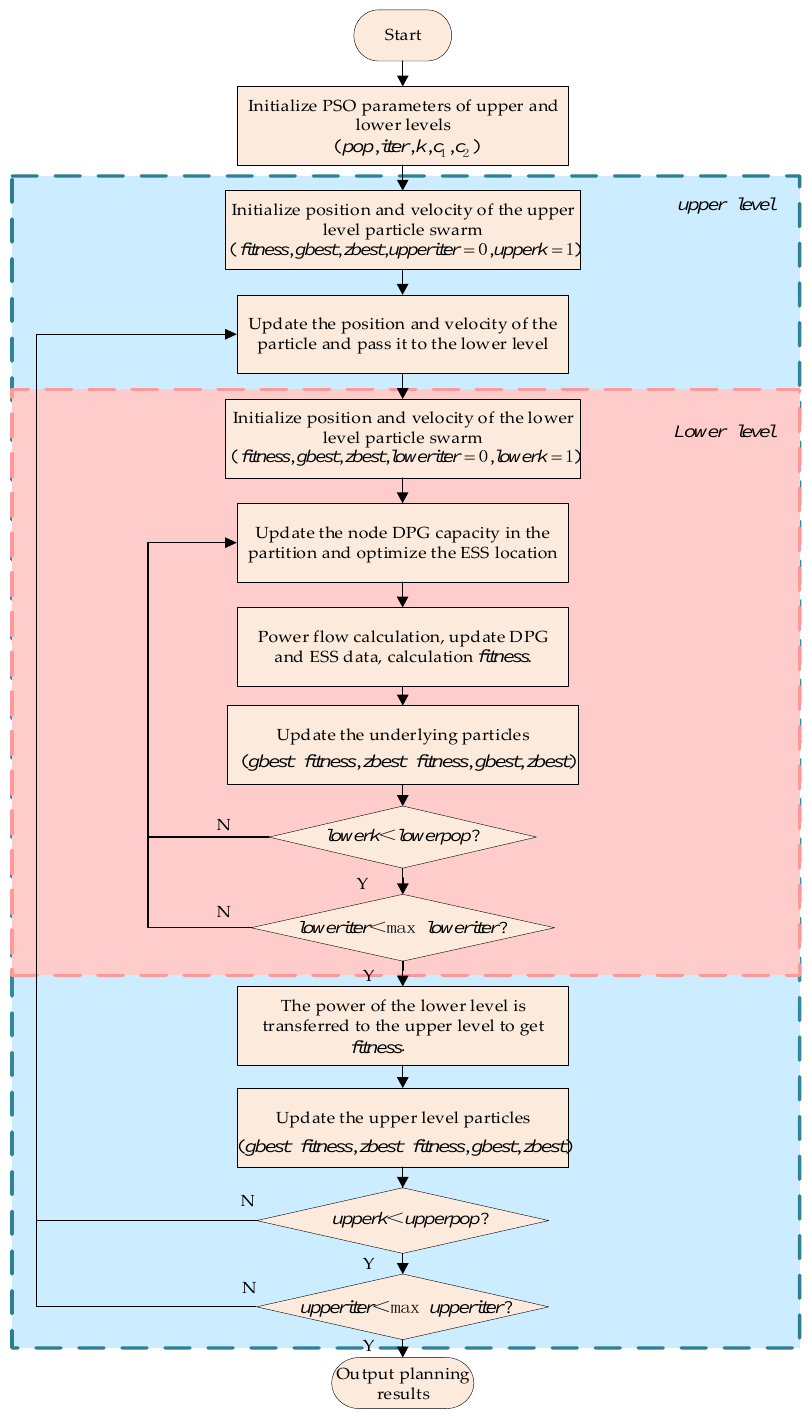
Figure 4. Bilevel nested PSO algorithm for distribution network.